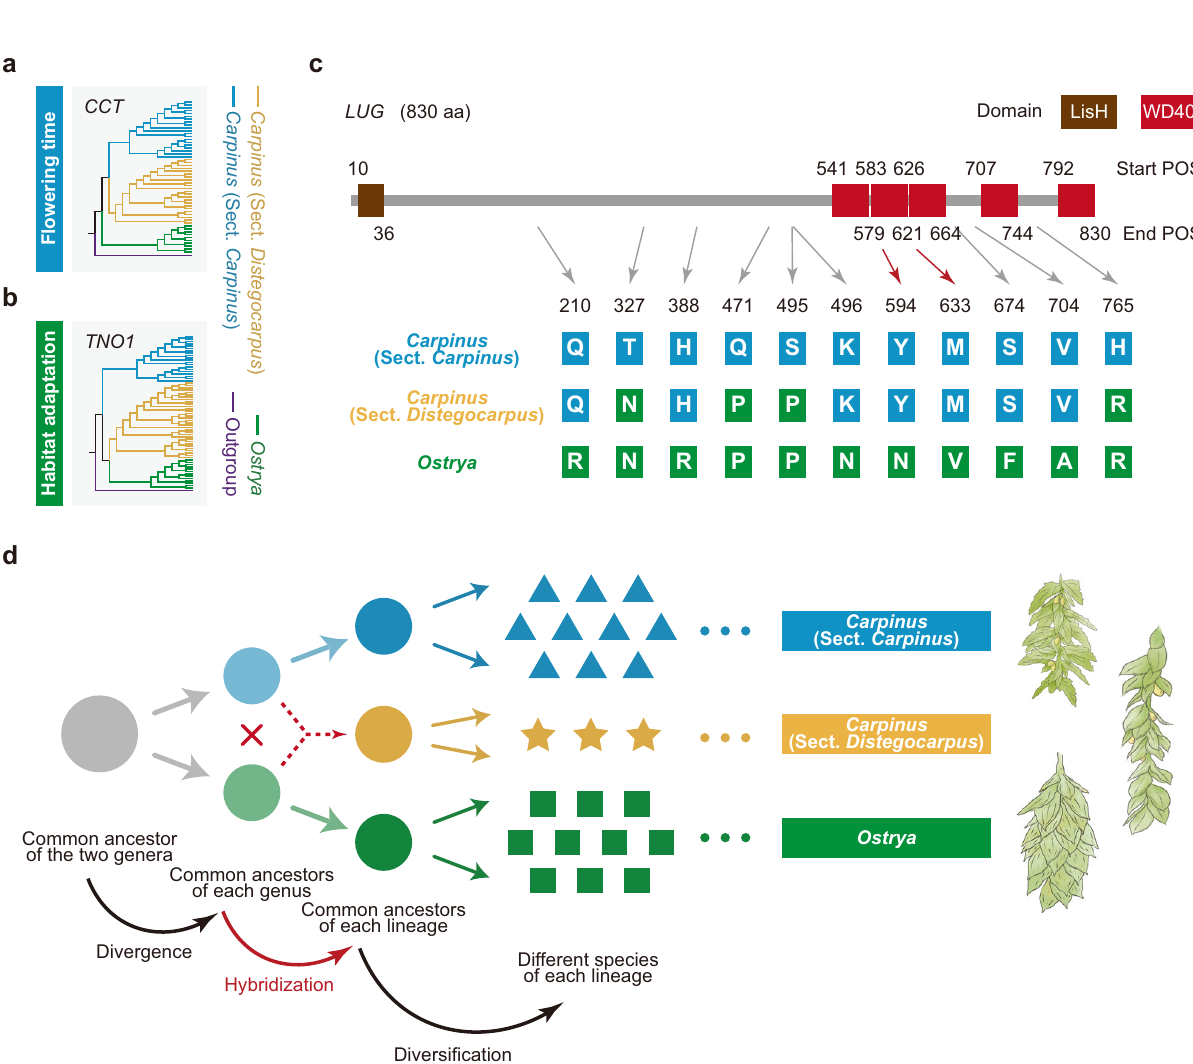
Fig. 6 Selected PSGs involved in RI barriers and the LUG gene showing hybrid signals. a , b Two selected RI-related PSGs of sect. Distegocarpus derived from sect. Carpinus ( a ) and Ostrya ( b ) respectively. ML trees were constructed based on haplotypes of protein sequences from all re-sequenced individuals. Each branch represents one identi fi ed haplotype. c The LUG gene showing hybrid signals because of hybrid recombination. All inter-lineage fi xed amino acid differences were shown. d A simpli fi ed model of an ancient intergeneric HHS event between two genera and further species diversi fi cation. Representative morphologies of nutlet bracts from three lineages are shown on the right (Top: sect. Carpinus ; middle: sect. Distegocarpus ; bottom: Ostrya ). In ( a – c ), the different background colors indicate the alleles ( a , b ) and mutations ( c ) of sect. Distegocarpus derived from sect. Carpinus (blue) and Ostrya